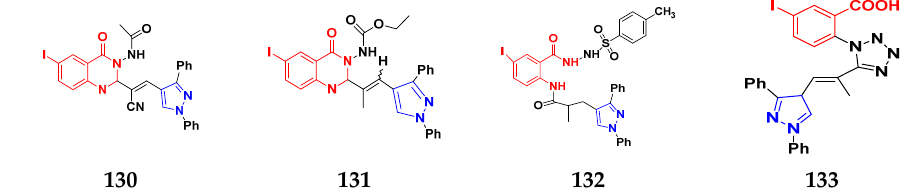
Figure 122. Structure of quinazoline-pyrazole-based derivatives ( 129 – 131 ) and pyrazole derivative ( 132 – 133 ). Table 109. In vitro cytotoxic activities of quinazoline-pyrazole-based compounds ( 129 – 131 ) and pyrazole derivatives ( 132 – 133 ).